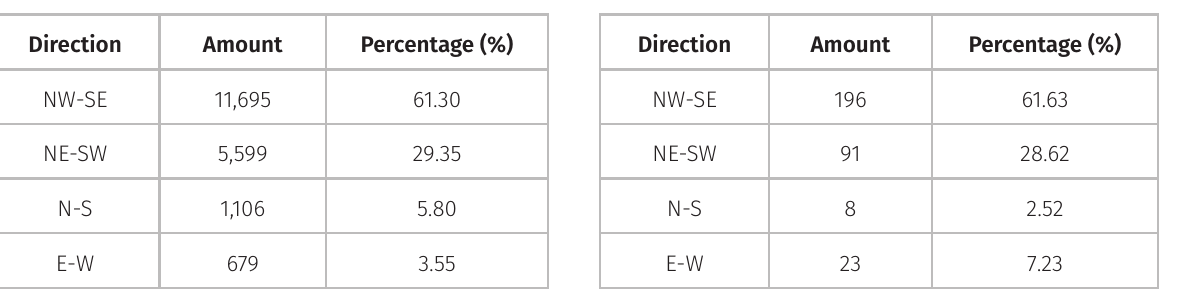
Table III. Statistical analysis of linear features extracted by the LINE algorithm.